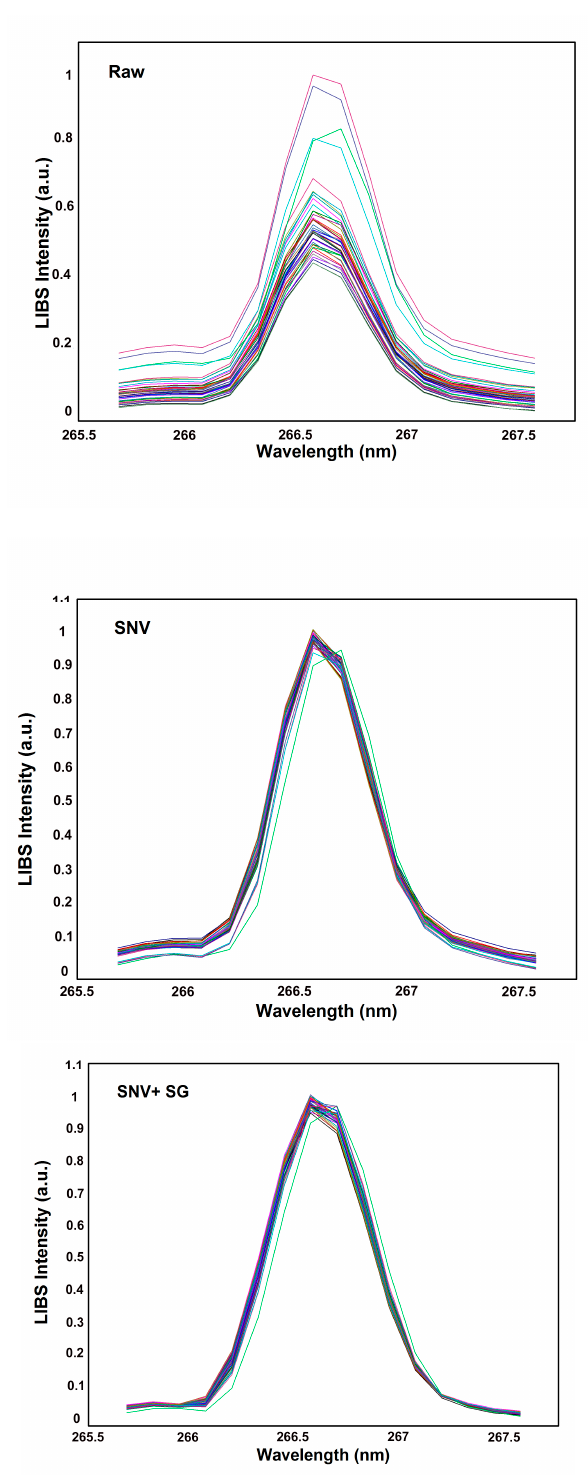
Figure 7. Raw, SNV, and SNV + SG LIBS spectra of the transition of Fe II at 266.663 nm.